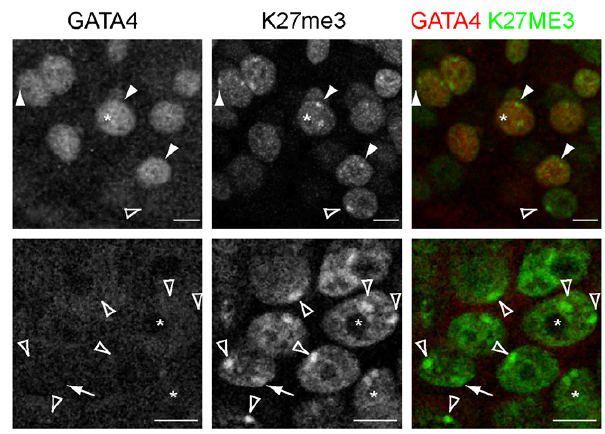
Figure 7. H3K27me3 accumulation in trophectoderm and hypoblast precursors. Expression of GATA4, and H3K27me3 in human embryos that have been co-cultured with decidualized endometrial cells for 72 h. Closed arrowheads denote GATA4 positive cells with H3K27me3 foci. Open arrowheads denote trophectoderm cells negative for OCT4 and GATA4 with distinct H3K27me3 foci. The asterisks mark cells with two H3K27me3 foci. Arrows mark the location of a diffuse H3K27me3 domain. Scale bars are 10 m m.